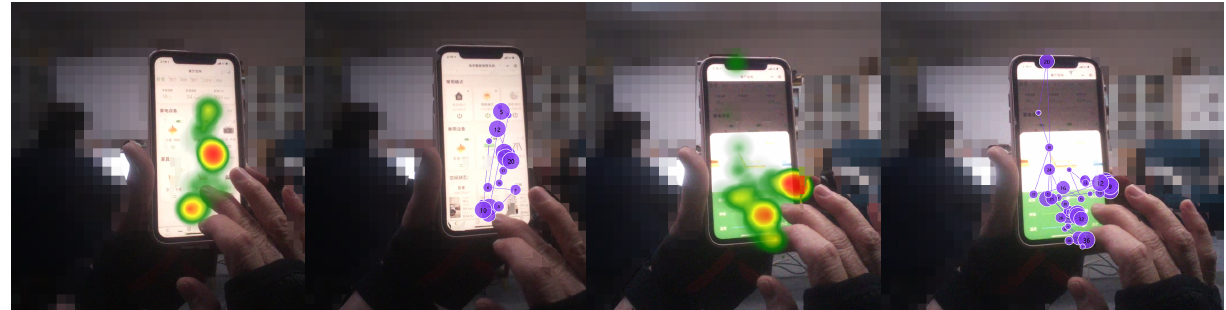
Figure 4. Eye movement hotspot maps and eye movement trajectory maps in elderly subjects of different genders. The darker the colour on the heat map, the more attention the area received. The numbers in the trajectory diagram represent the order in which the eyes are